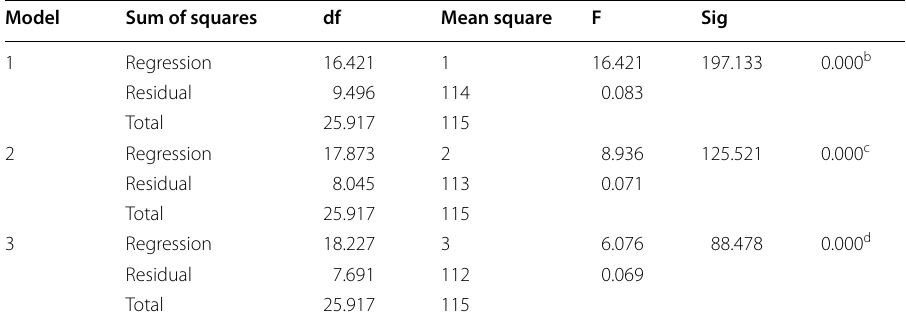
a Dependent Variable: learning outcomes b Predictors: (Constant), cognitive c Predictors: (Constant), cognitive, social d Predictors: (Constant), cognitive, social,